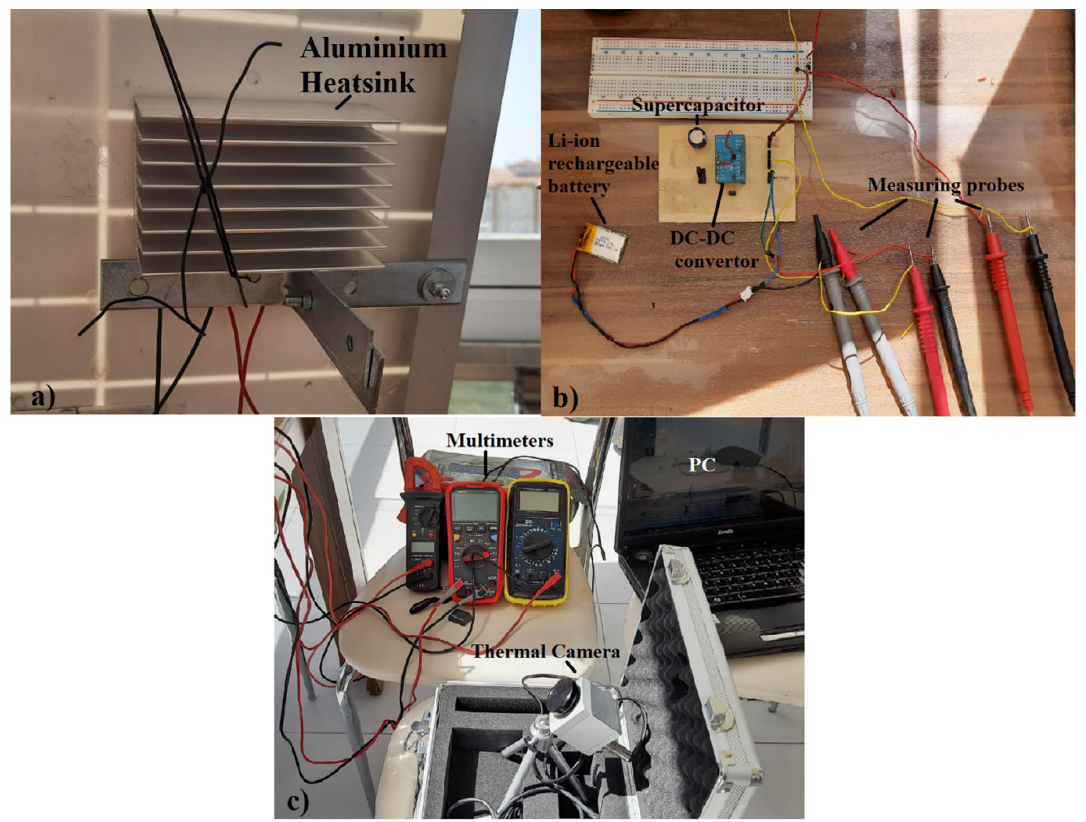
Figure 7. ( a ) TEG and aluminium heat sink placed behind the photovoltaic panel, ( b ) DC ‐ to ‐ DC convertor with li–ion rechargeable battery, and ( c ) test instrumentation including thermal camera, multimeters and personal